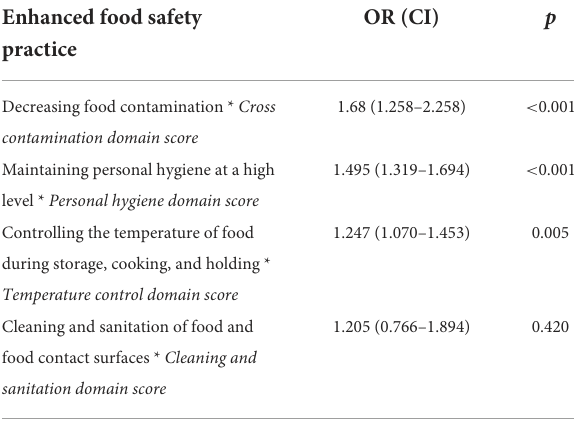
TABLE 10 Binary logistic regression of enhanced food safety measures during the COVID-19 pandemic of the study population and the aligned food safety domain score ( n =